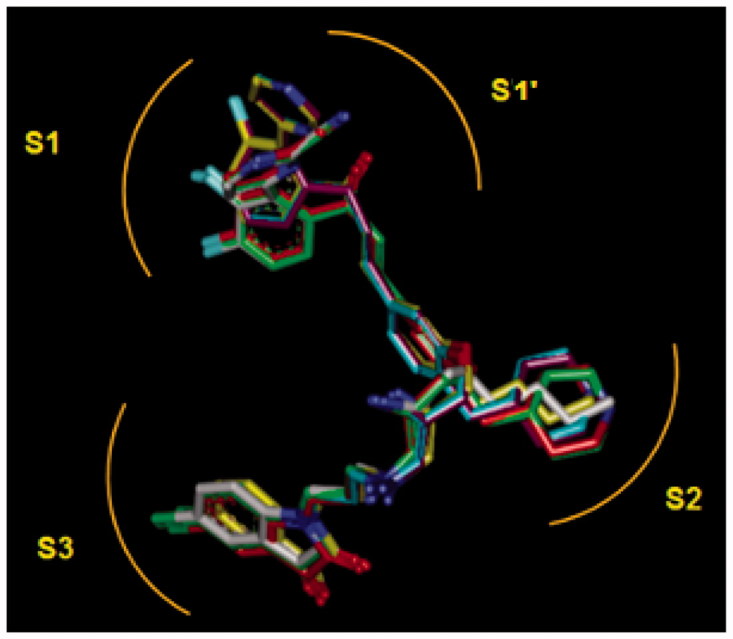
Superimposition of the best analogues exploring the S2 pocket of FP-2 active site; 125–1-1-H-lki-128 (green, IC
50
pre = 13 nM), 125–1-1-H-lki-129 (red, IC
50
pre = 15 nM), 125–1-1-H-lki-134 (orange, IC
50
pre = 18 nM), 127–1-1-H-lki-128 (purple, IC
50
pre = 13 nM), 127–1-1-H-lki-129 (blue, IC
50
pre = 15 nM), 127–1-1-H-lki-134 (white, IC
50
pre = 15 nM).